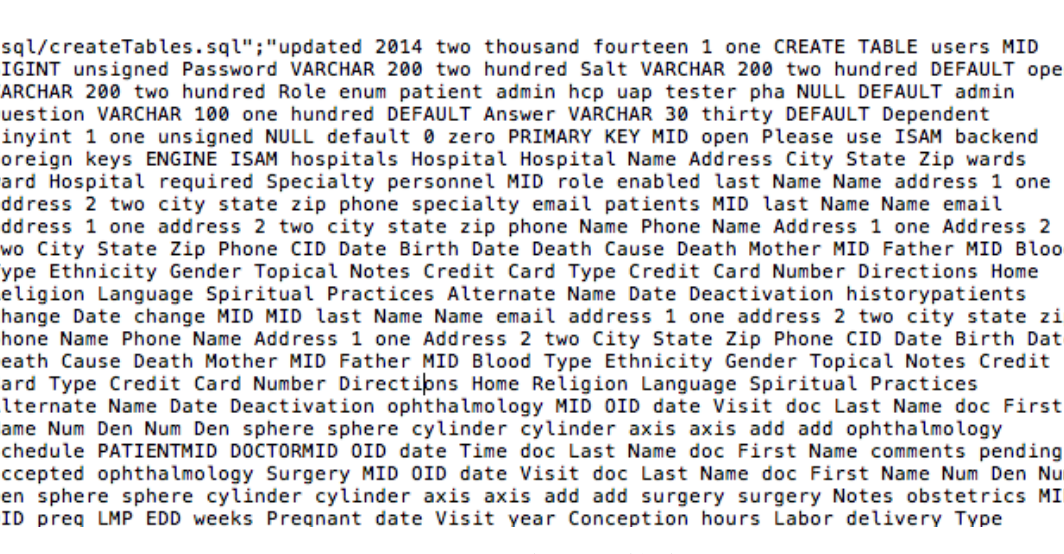
Figure 5: Fragment of corpus file for iTrust